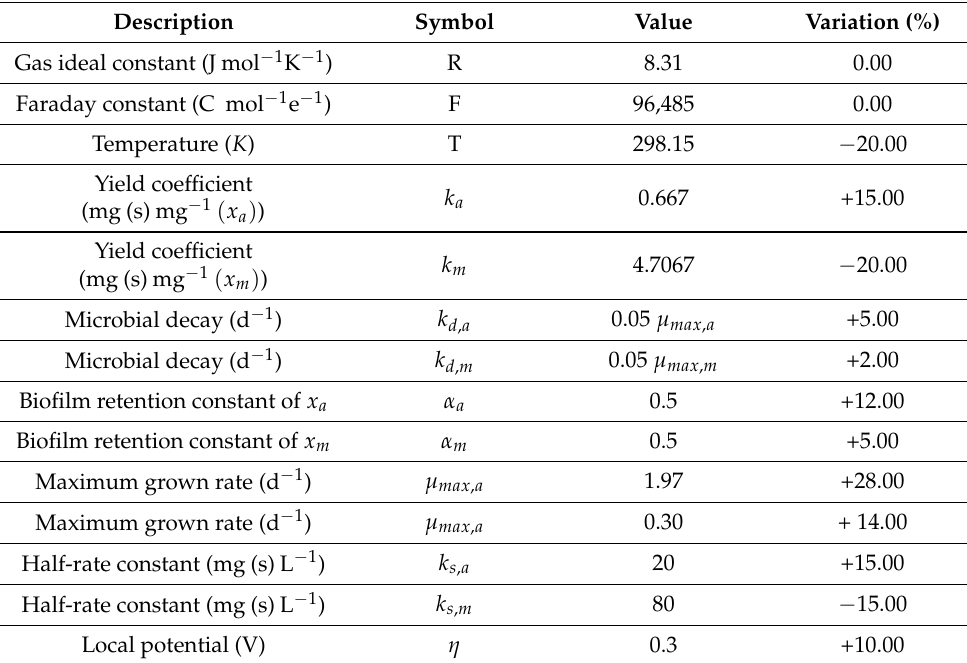
Figure 13. Implementation scheme for numerical simulation tests Table 2. MEC Model parameter with